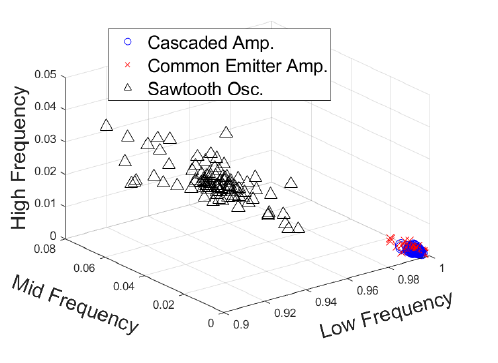
Figure 15. Fourier feature space representation of second and third harmonics data, SNR=2 dB.